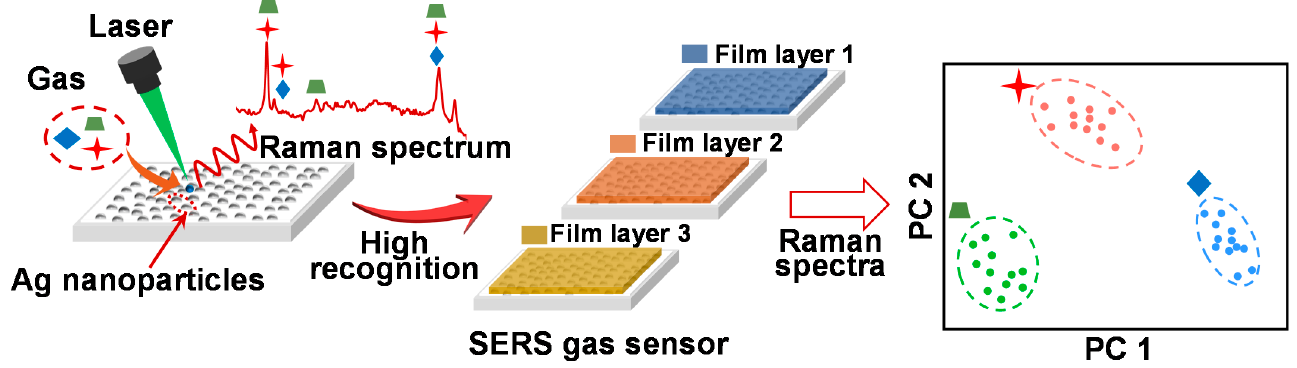
Figure 1. The schematic graph of the polymer film array for gas recognition.